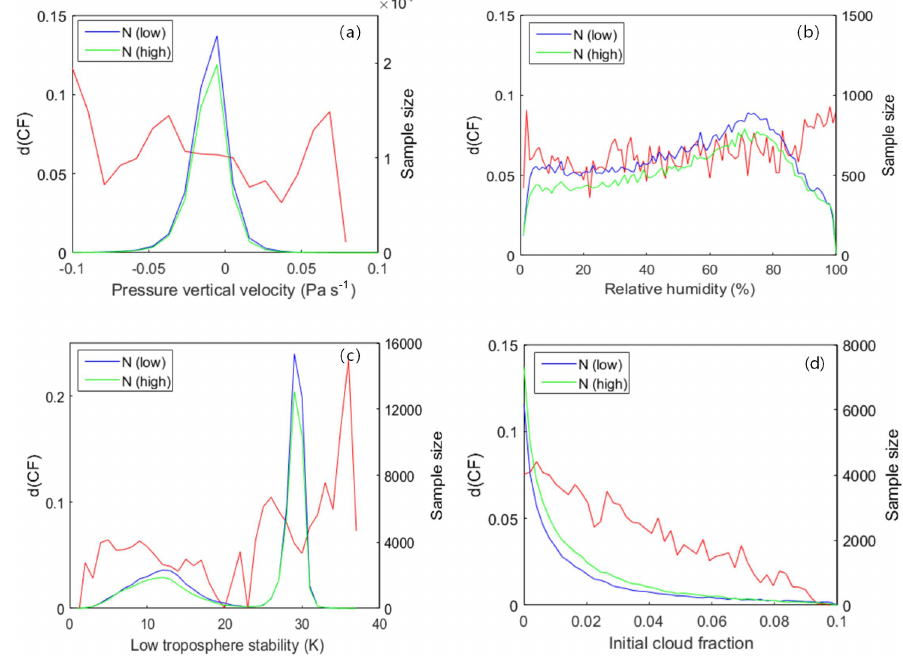
Figure 8. Variation of d(CF) (red) as function of initial meteorological parameters and cloud fraction for warm clouds when the cloud cover increases under both low- and high-AOD conditions over land after the 3h time step. The distribution of points for low (blue) and high (green) AOD as a function of meteorological parameters is shown by the solid lines. This plot is composed from MODIS data (including Terra and Aqua) for all warm cloud points over the years 2008–2017. Meteorological parameters are plotted along the horizontal axis, the left vertical axis denotes d(CF), and the right vertical axis denotes the number of high- and low-AOD